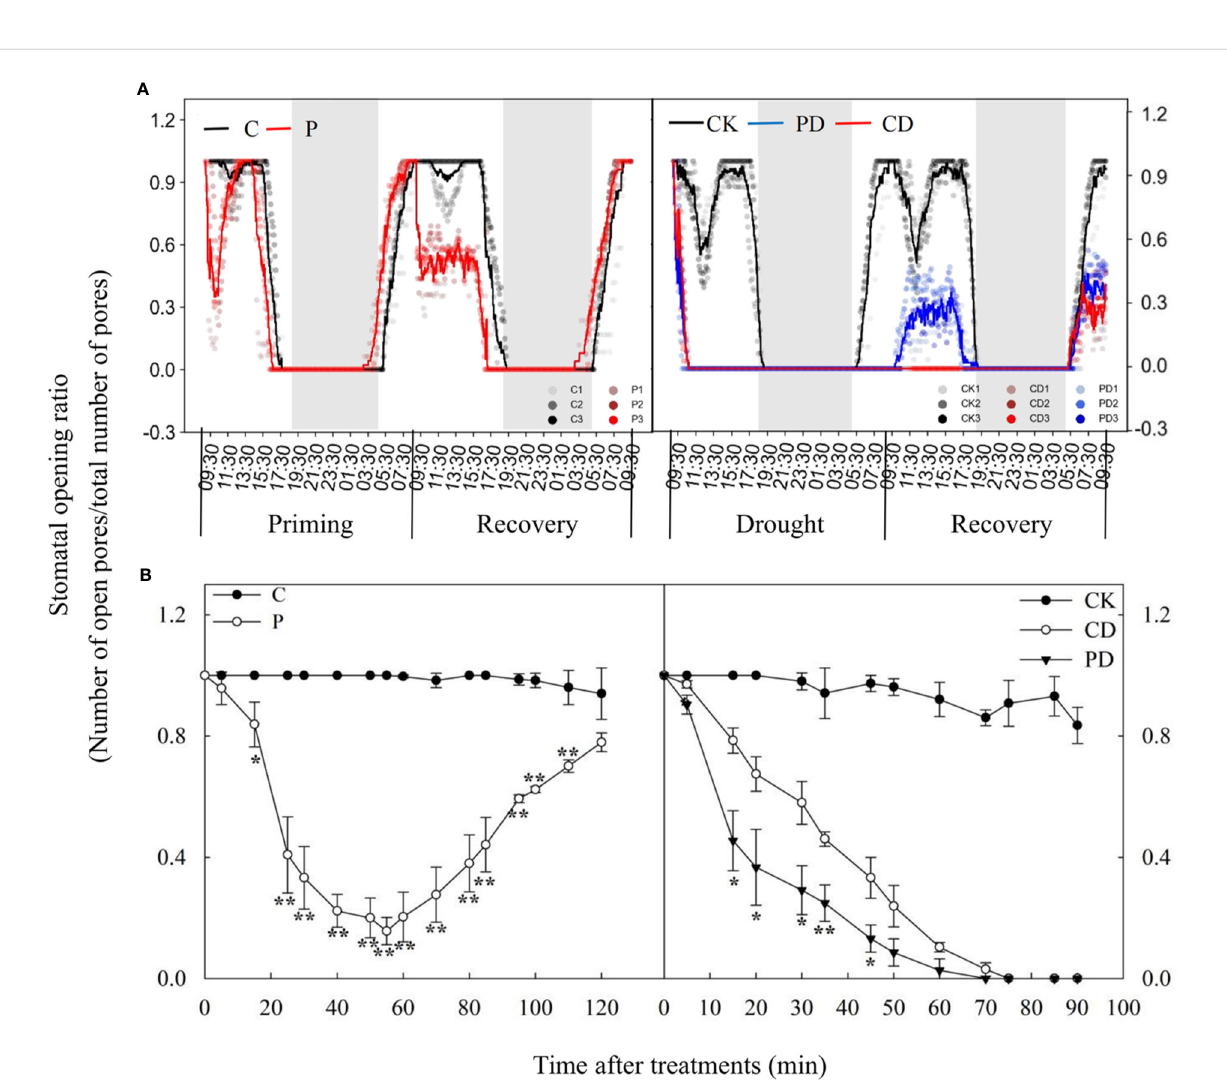
FIGURE 1 Dynamic responses of stomatal opening ratios during “ drought priming-recovery-drought stress-recovery ” in wheat. (A) Stomatal opening ratio during “ drought priming-recovery-drought stress-recovery ” . (B) Stomatal opening ratios of drought priming within the fi rst 2h and of drought stress within the fi rst 1.5h. The horizontal axis denotes time in (A) and treatment time (min) in (B) . Drought priming and drought stress start at 9:00 am on the fi rst day and stop at 9:00 am on the second day (start of the recovery stage). Lines are an average of three independent replicates. The white and black rectangles represent day and night, respectively. C, no drought priming; P, priming; CK, no drought priming + no drought stress; PD, priming + drought stress; CD, no priming + drought stress. *p < 0.05; **p < 0.01.